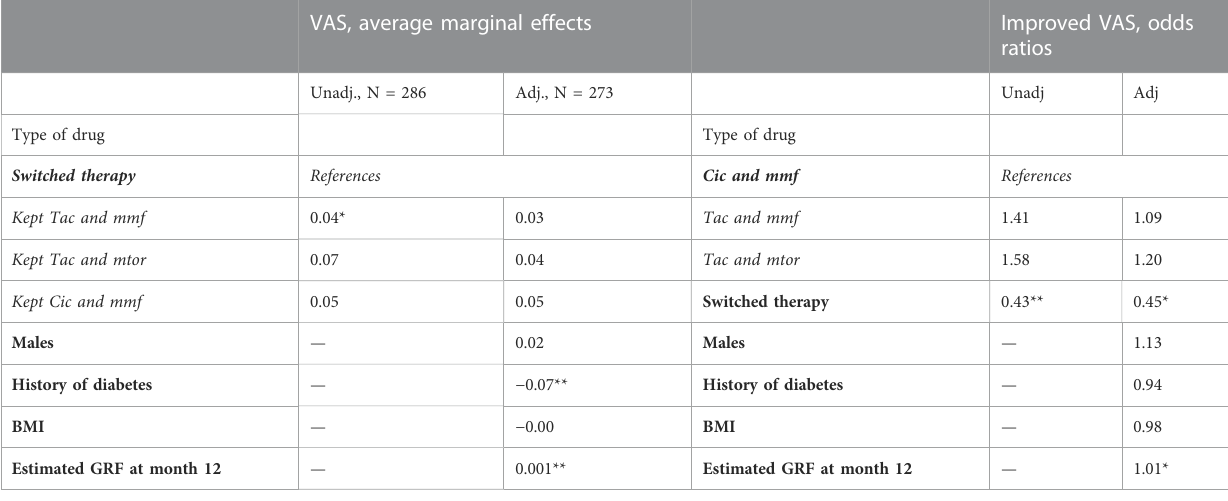
TABLE 3 VAS scores at closing visit M12 and improvement of VAS score over the whole observation period.